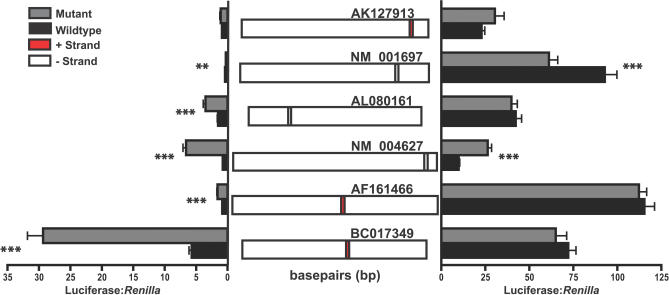
Luciferase Activity in HeLa Cells of General Promoters before and after the Introduction of a Single GABP SiteThe center of the graph depicts the promoters labeled by their defining cDNA as the cloned sequence used in our assays in 5′ to 3′ orientation on the sense strand for their respective genes with the introduced GABP site, CCGGAAGTG, depicted as bands in either red or white depending on whether the site was introduced in the + or − orientation, respectively. The black bars depict the average luciferase to Renilla ratio of the wild-type promoter sequence along with standard error of the mean error bars. The gray bars depict the average promoter activity after the introduction of the GABP site. Asterisks indicate the degree of significance, as determined by Welch's t-test for unequal variances.